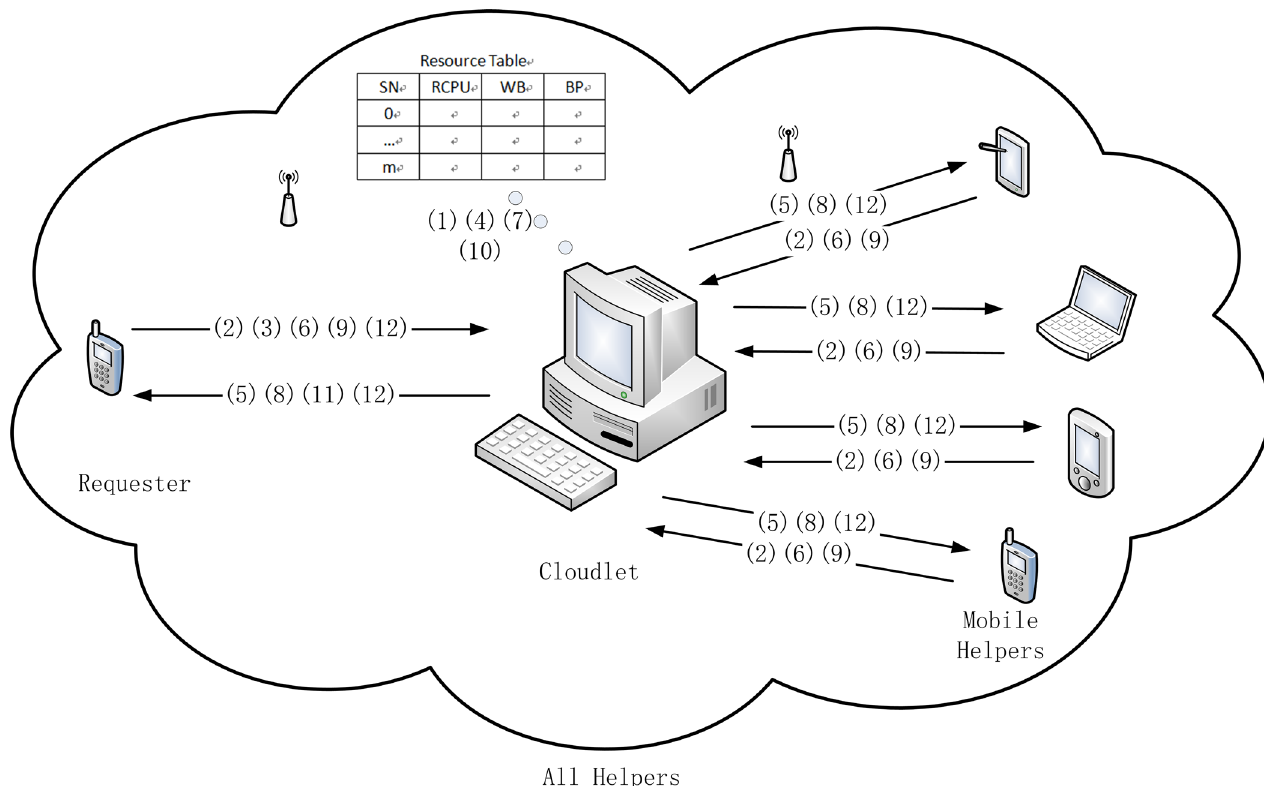
Fig 1. Compounded local mobile cloud architecture. This model is used to present the execution process of CLMCA